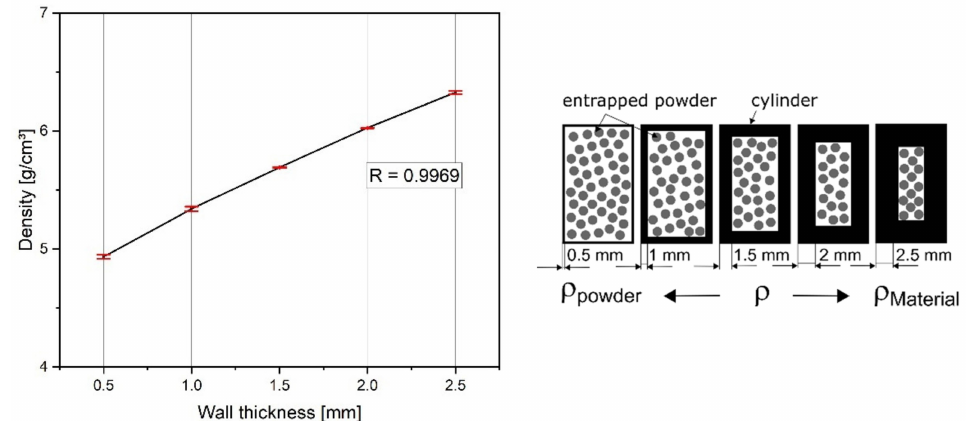
Figure 13. ( Left ) Density of the as-built PBF-EB thin-walled closed cylinder. Reduced density for small wall thicknesses indicates that there is no open porosity in the walls. ( Right ) Density of thick-walled closed cylinders tends to material density.